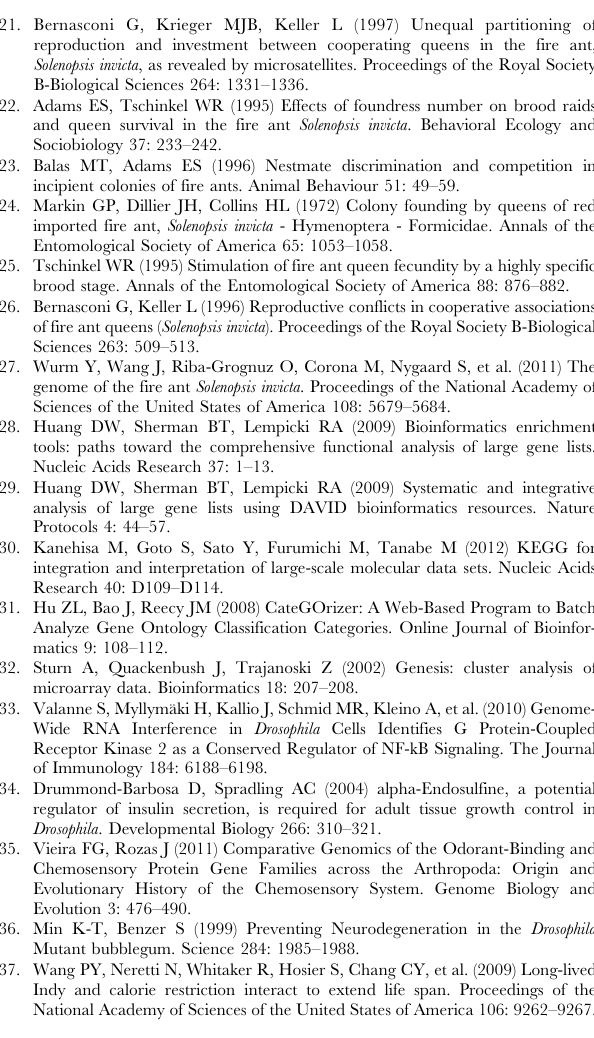
Table S13 Comparative studies: GO analysis of overlapping transcripts that were significantly differentially regulated (P , 0.1) between win and los in experiment 1 and experiment